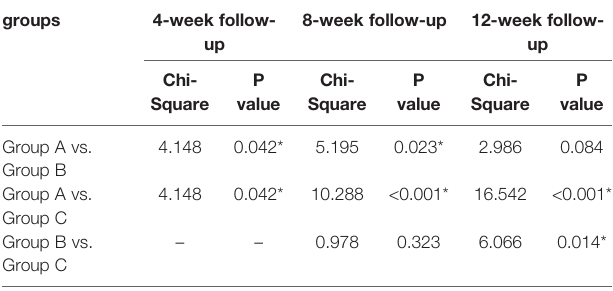
TABLE 3 | The differences of chi-square statistical outcome in percentage of MCID cases between each two groups.